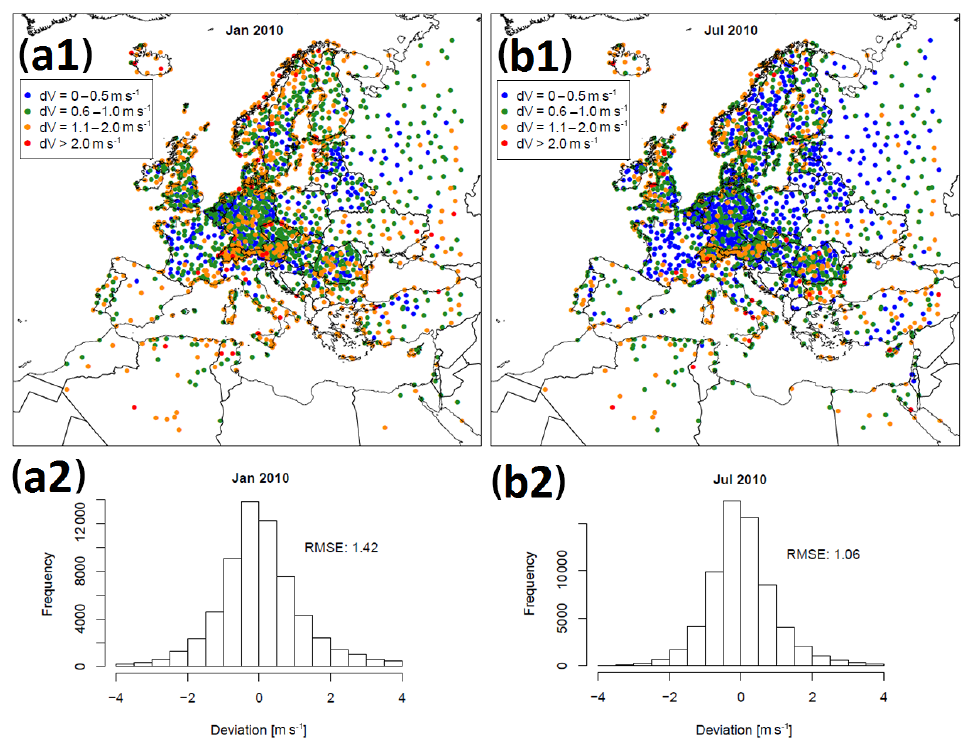
Figure 17. Cross-validation results for daily mean wind speed data January 2010 (a1, a2) and July 2010 (b1, b2) . The color code indicates the monthly mean of the daily absolute deviations. The histograms contain the full statistics of deviations over all days and